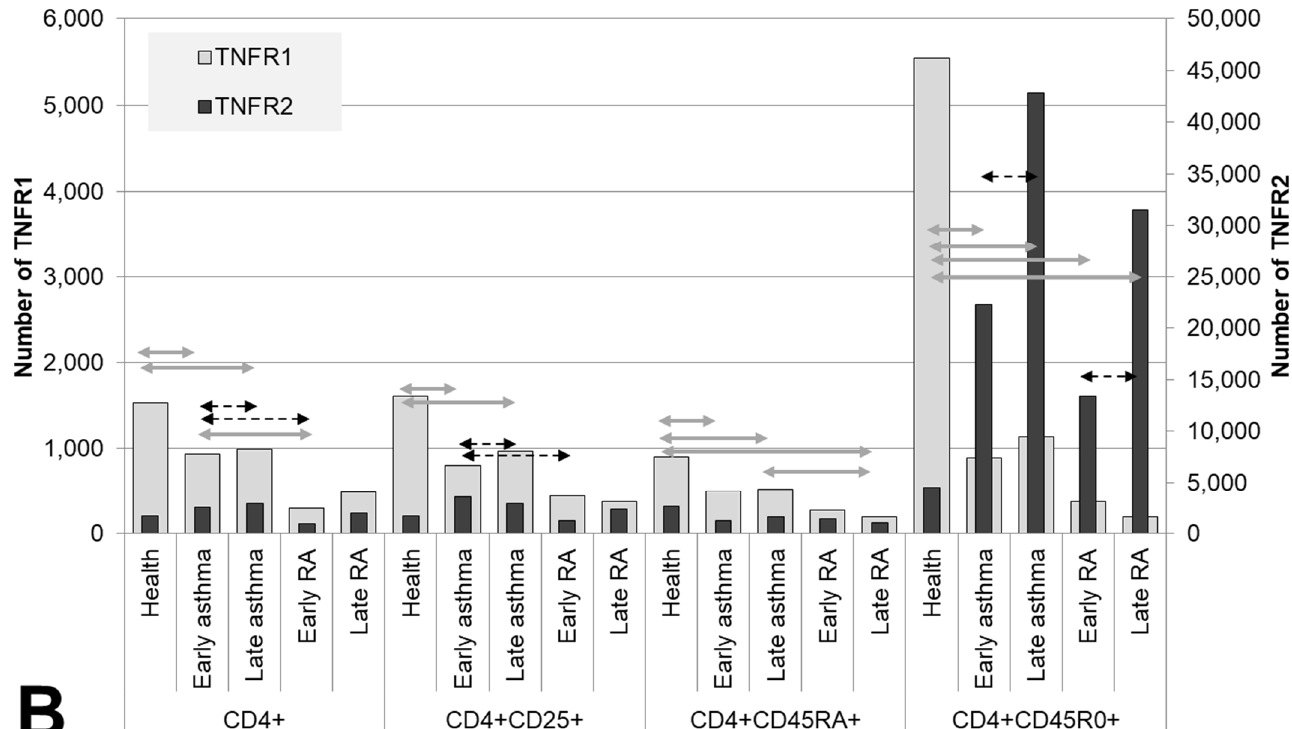
Figure 2. Co-expression (A) and density (B) of TNF receptors of types 1 and 2 in T helper cells subpopulations. Arrows indicate significant ( p < 0.05, Kruskal–Wallis test for multiple comparisons) differences in the expression level of TNFR1 between healthy individuals and RA patients or asthma and between patients at the same stage of the disease (between early RA and early asthma and between late RA and late asthma). Light grey arrows indicate differences for TNFR1; dark grey arrows indicate differences for TNFR2.